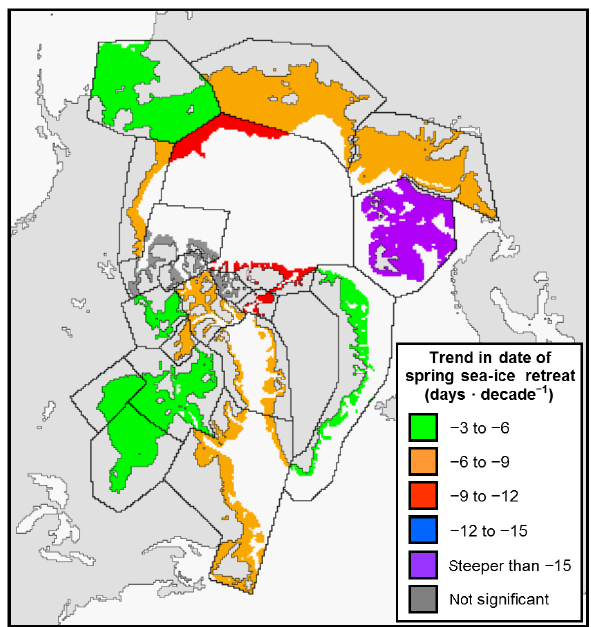
Figure 10. Trend map of the date of spring sea-ice retreat for the shallow parts of each PBSG region. Trends are also given in Table